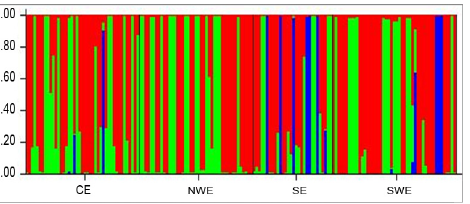
Fig 3. Bayesian model-based estimation of population structure ( K = 3) for the 163 Colletotrichum gloeosporioides isolates in four pre-determined populations (x-axis): Central Ethiopia (CE), Northwest Ethiopia (NEW), South Ethiopia (SE) and Southwest Ethiopia (SWE). Each group is separated by a black vertical line. Numbers in the y-axis show coefficient of